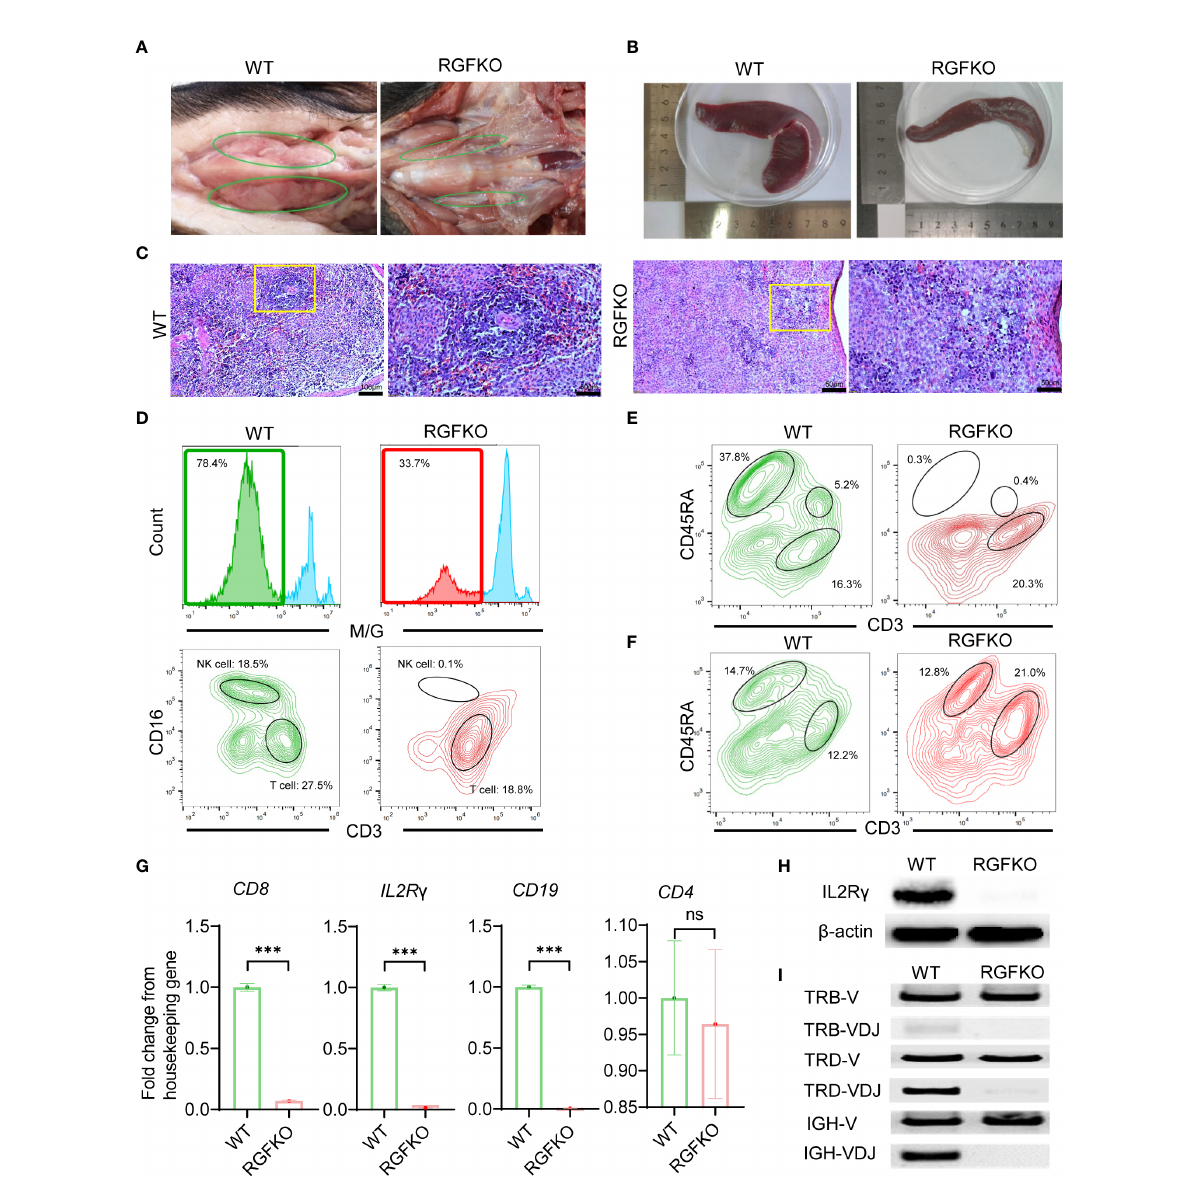
FIGURE 3 Immunological characterization of RGFKO pigs. (A) Representative images of the thymus of wildtype (WT) and RGFKO pigs. (B) Representative images of the spleen of WT and RGFKO piglets. (C) Representative spleen sections of WT and RGFKO piglets stained with hematoxylin and eosin. Left: normal spleen architecture in WT pig; Right: lacked lymphoid follicles and germinal centers, as well as reduced lymphoid aggregation in the white pulp in RGFKO pig. Boxed region indicating the white pulp region was further magni fi ed. (D – F) Flow cytometric analysis of the peripheral blood (D, E) and splenocytes (F) of WT and RGFKO piglets. (D) Shown are representative images of histograms of macrophage/granulocyte (M/G) marker staining. The boxed region, representing M/G negative population, is further gated upon for T cells (M/ G-CD3 + CD16 - ) and NK cells (M/G-CD3-CD16 + ) analysis. (E, F) Shown are representative plots of CD45RA against CD3. B cells are identi fi ed as CD3 - CD45RA + . Numbers indicate the proportion of the indicated population as a percentage of total peripheral blood mononuclear cells (D, E) or splenocytes (F) . (G) qPCR analysis of the expression of the indicated genes in splenocytes of RGFKO and WT piglets. Shown are fold change of the indicated genes over housekeeping gene (GAPDH). Data shown are mean ± standard error (n = 2 for RGFKO, n = 3 for WT). ns: not signi fi cant. *** p < 0.001. (H) Western blot analysis of the expression of IL2R g in splenocytes of RGFKO and WT piglets. b -actin was used as a loading control. (I) PCR analysis of germline TRB-V, TRD-V and IGH-V genes, and V(D)J-recombined TRB-VDJ, TRD-VDJ and IGH-VDJ genes in splenocytes of RGFKO and WT pigs. Shown are representative images of PCR ampli fi cation products visualized by DNA gel